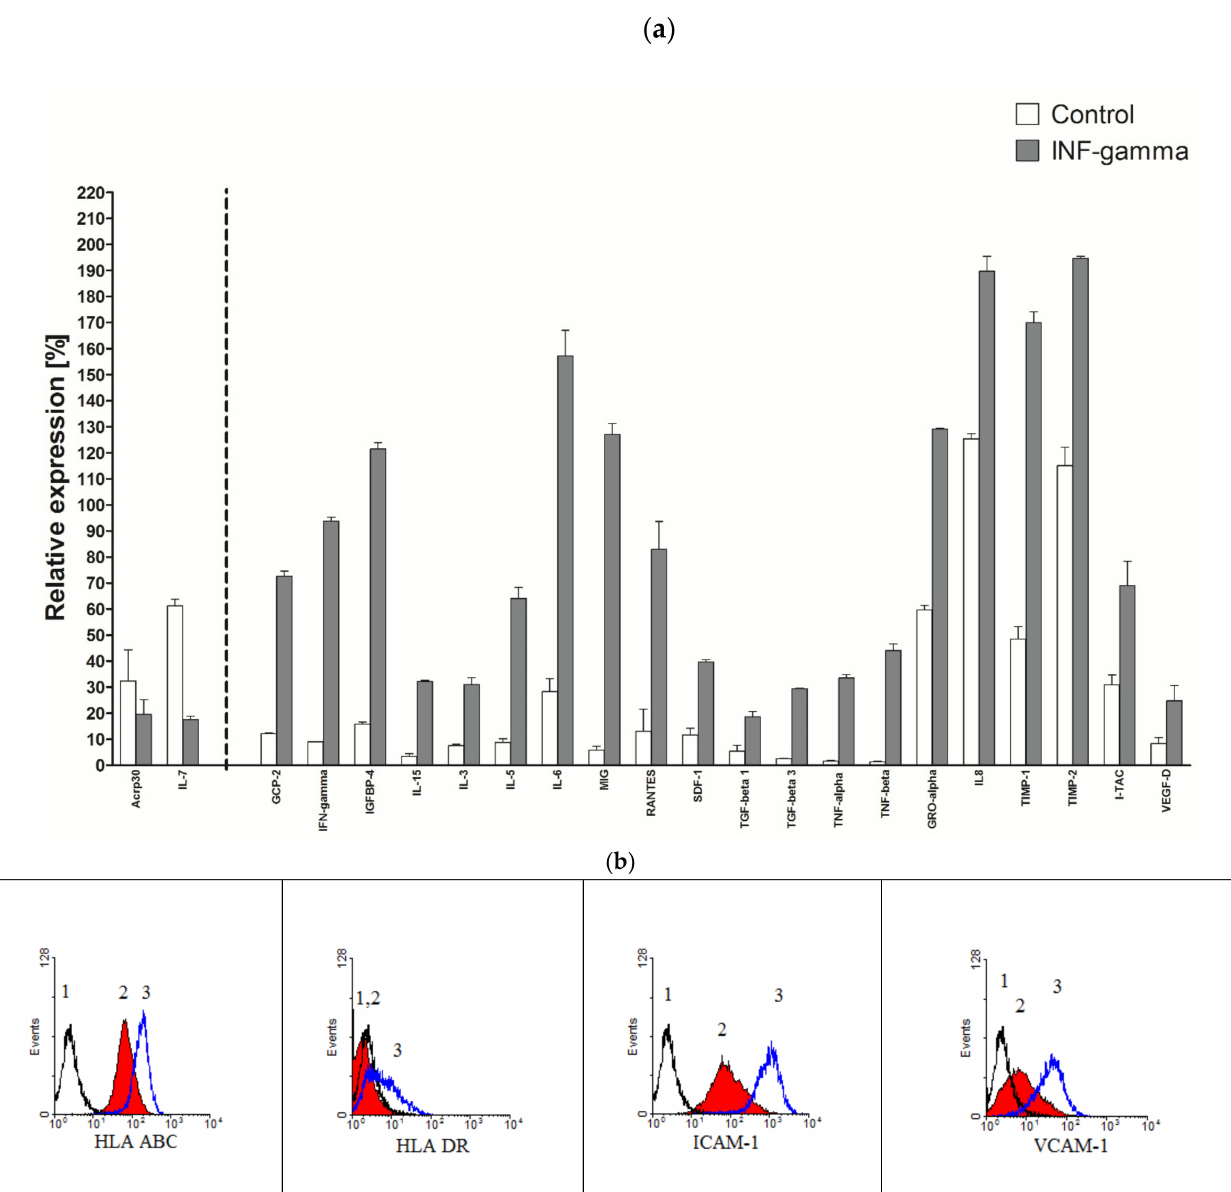
Figure 9. Selected cytokine production after a 24 h INF-gamma stimulation of cell culture. ( a ) The secretory profile of the tested line was determined using the RayBio C-series Human Cytokine Antibody Array for a panel of 120 cytokines and